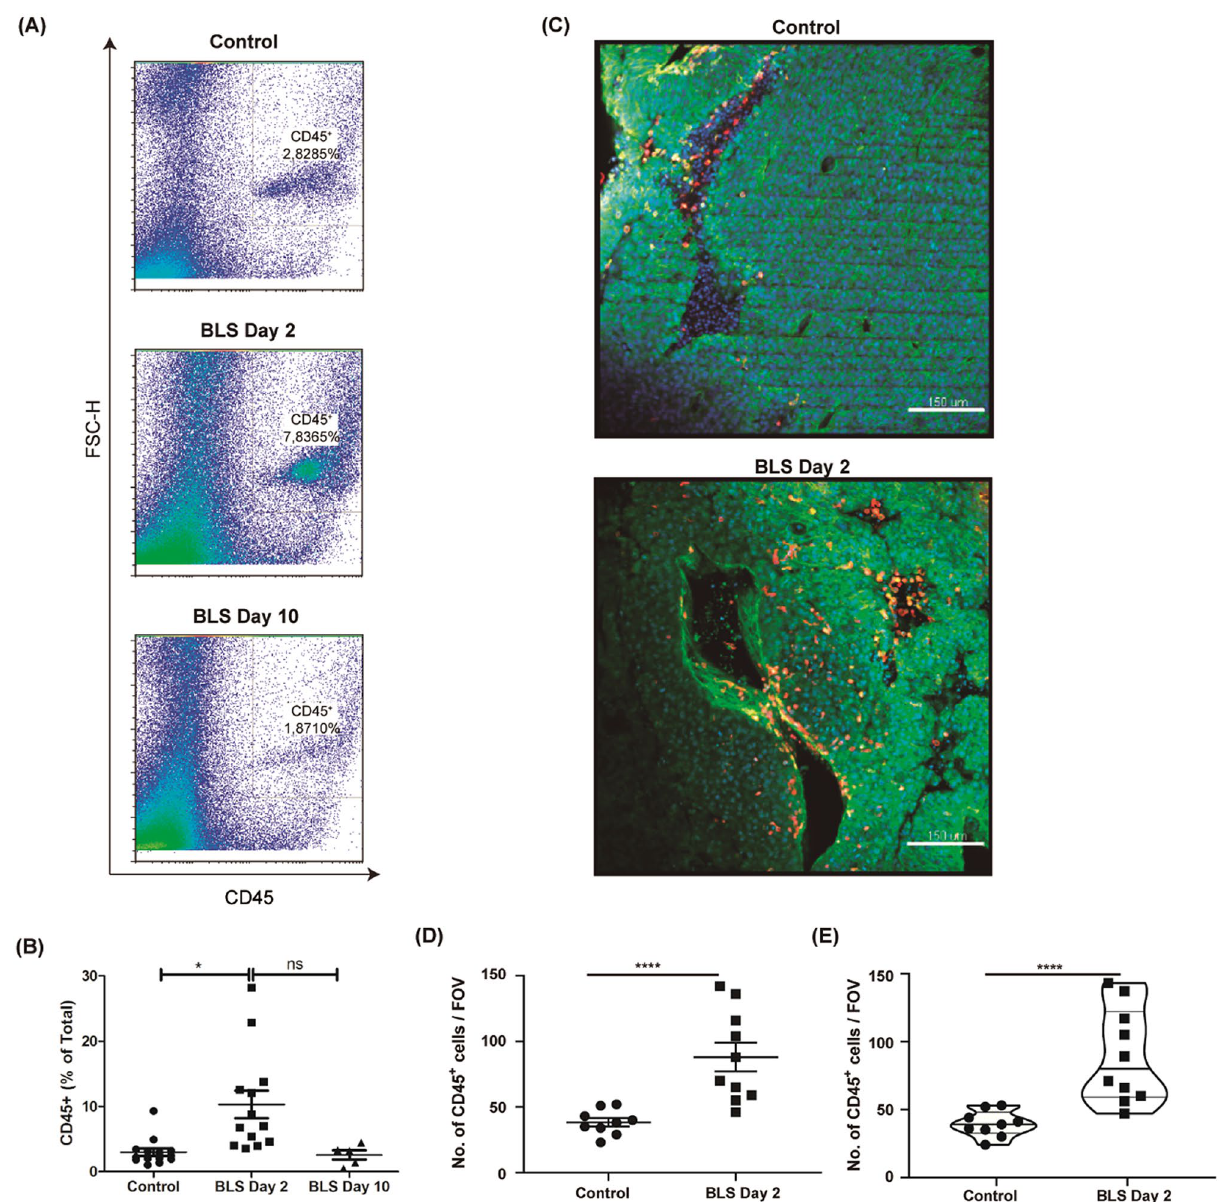
Figure 2. BLS administration impacts in the tumor microenvironment composition. C57BL/6J mice were inoculated with 1.25 × 10 5 B16 cells subcutaneously in the right flank. At day 2 or 10, 200 μg of BLS or PBS (control) were subcutaneously administered in the base of the tail. At day 14 the abundance of CD45 + cells within the tumor was analyzed by flow cytometry as depicted in representative FACS plots ( A ) and quantified as % of Total live cells in ( B ). For ( C – E ), fixed precision cut tumor slices of 200 µm thickness were obtained and stained for phalloidin (Green, the tumor structure and blood vessels), CD45 (Red), and static z- stack snapshots were captured by taking a 1024 µm × 1024 µm field of view (FOV), under a ×20 dry objective using an inverted confocal microscope ( C ). In ( D ) number of CD45 + cells were quantified in a dot plot and violin plot ( E ) by compared between BLS-day 2 treatment and control (pooled data where each dot represents an individual tumor slice and 3 slices per individual mouse tumor). Data are representative from 2 individual or four independent experiments have been pooled (n = 3 mice per group per experiment). *p <